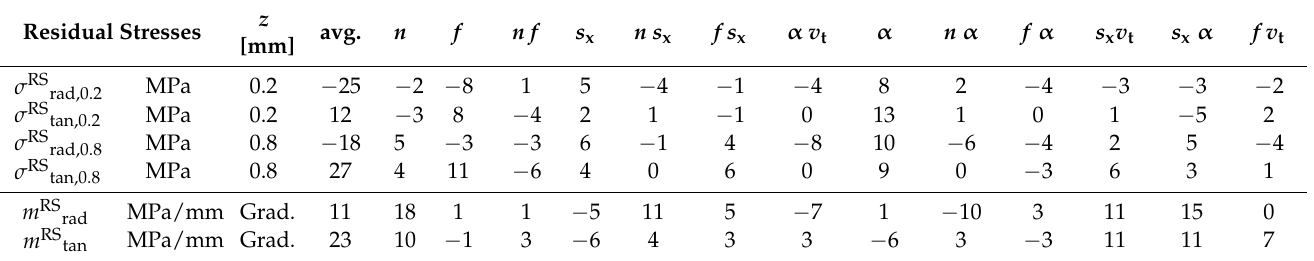
Table 5. Effects and interactions of the process parameters determined with the design of experiments (DoE) methods in z = 0.2 mm, z = 0.8 mm and gradient m RS of the residual stress depth distribution of flanges formed by friction spinning of aluminum (6060)